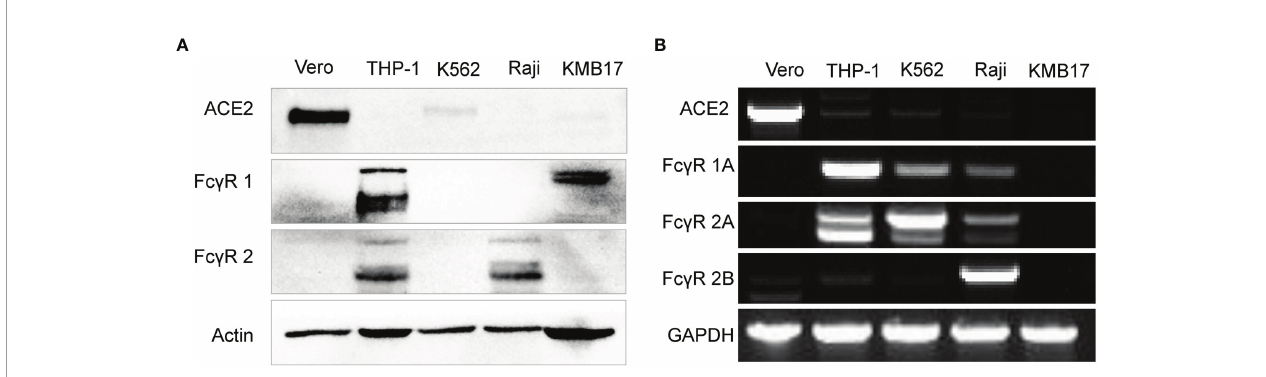
FIGURE 2 | Fc receptor expression patterns in immune cell lines. (A) The protein expression levels of ACE2, Fc g R1 and Fc g R2 were detected by Western blot. (B) The gene expression of ACE2 and more speci fi c Fc g R subtypes, including Fc g R1A, Fc g R2A, and Fc g R2B, was detected